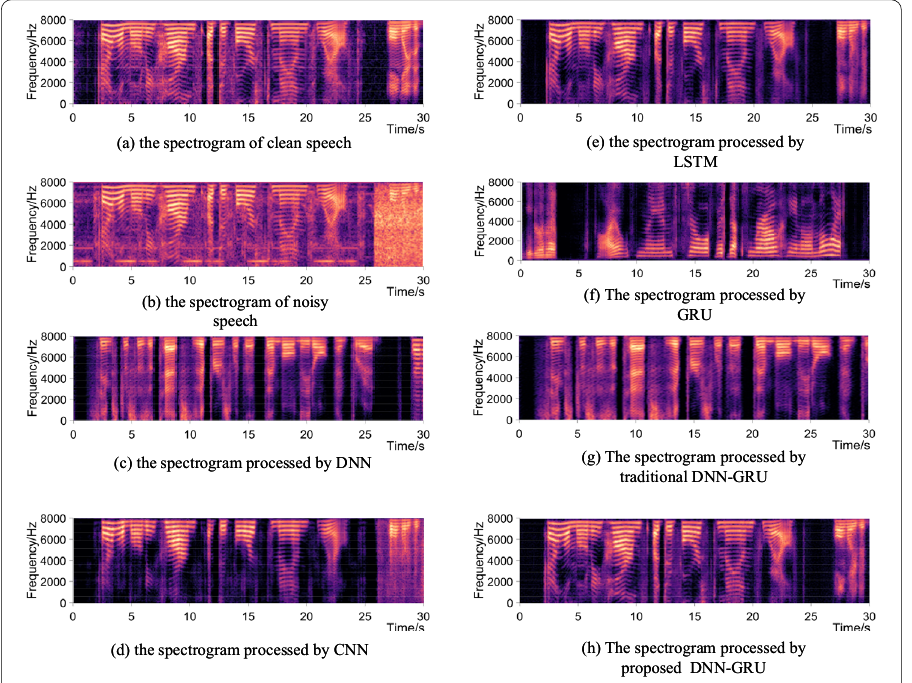
Fig. 9 Spectrograms of each